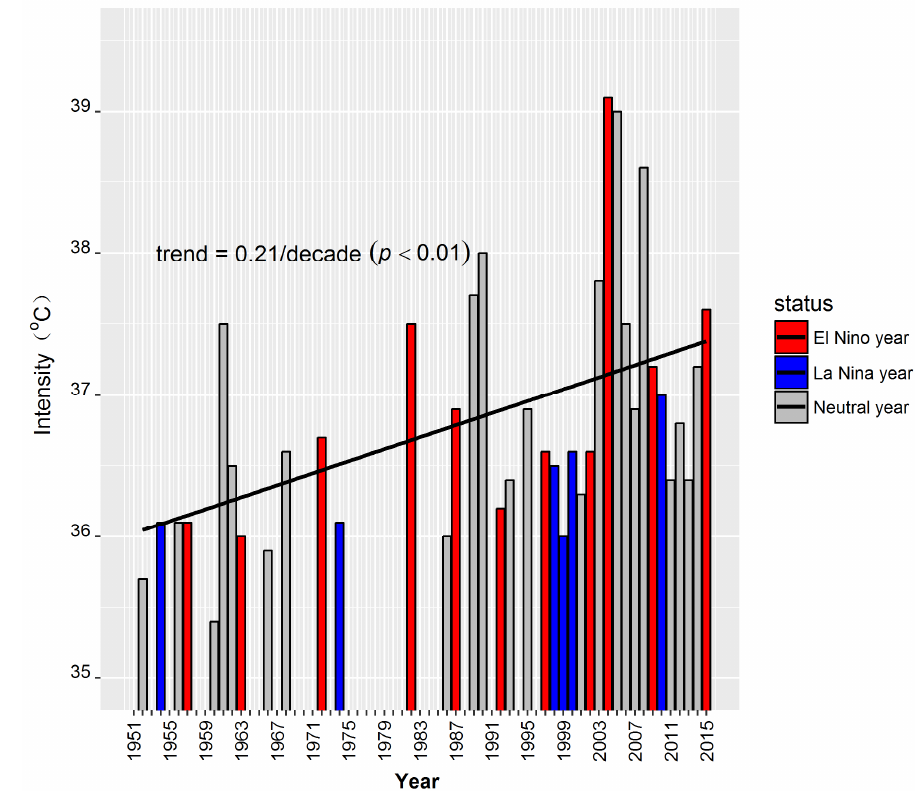
Figure 4. The intensity of heat waves in Guangzhou during 1951–2015. Annual intensity indicates the maximum value of daily maximum temperature during all heat waves in the year. The color of each bar shows the occurrence of El Niño years, La Niña years or Neutral years.